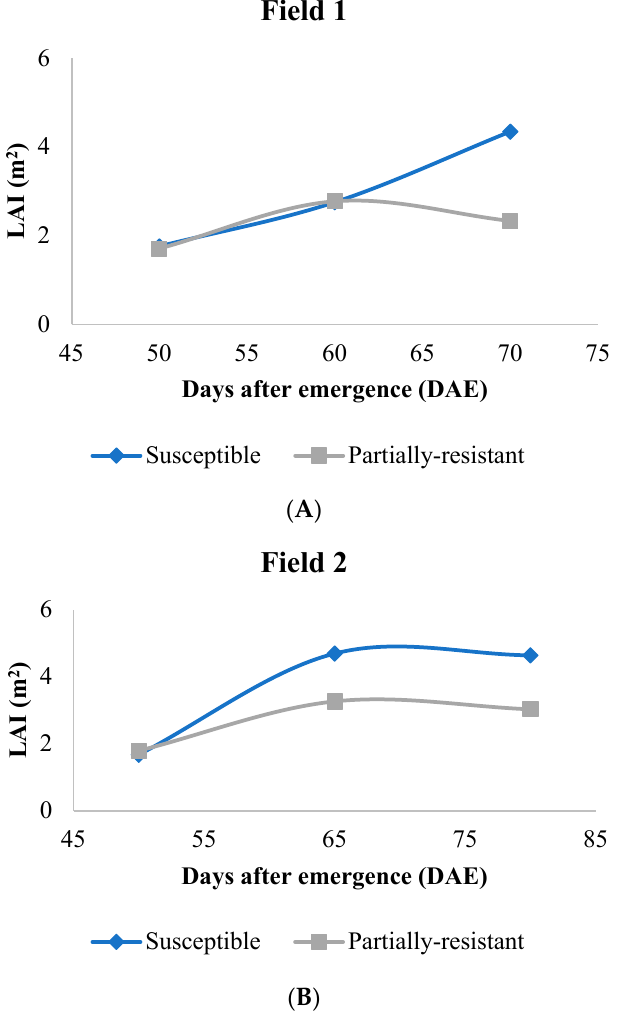
Figure 3. Leaf area index (LAI) of Field Trials 1 ( A ) and 2 ( B ) that were analyzed during the period interval of the fungicide applications.